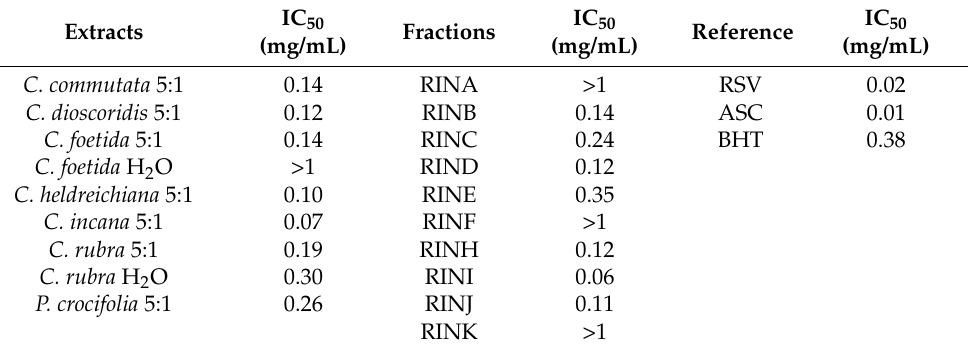
Table 3. Antioxidant effect of plant extracts, fractions and reference compounds, expressed as IC 50 values (DPPH assay). IC 50 IC 50 Extracts Fractions (mg/mL)